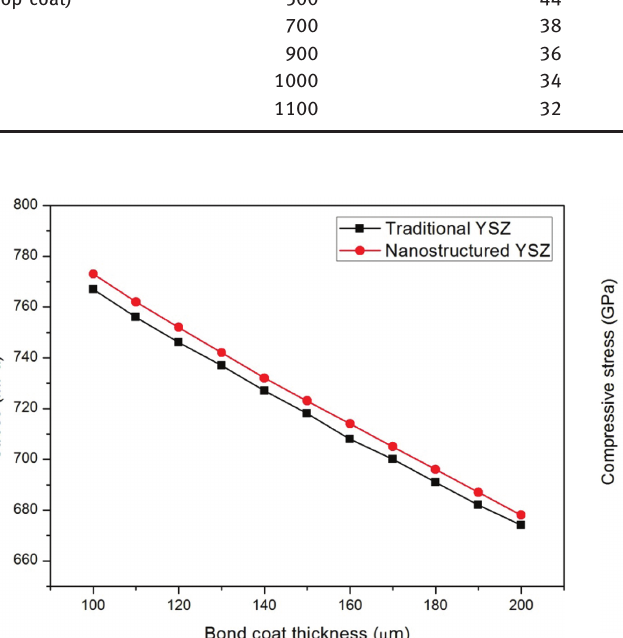
Figure 2: Radial tensile stress in traditional and nanostructured YSZ coatings as a function of bond coat